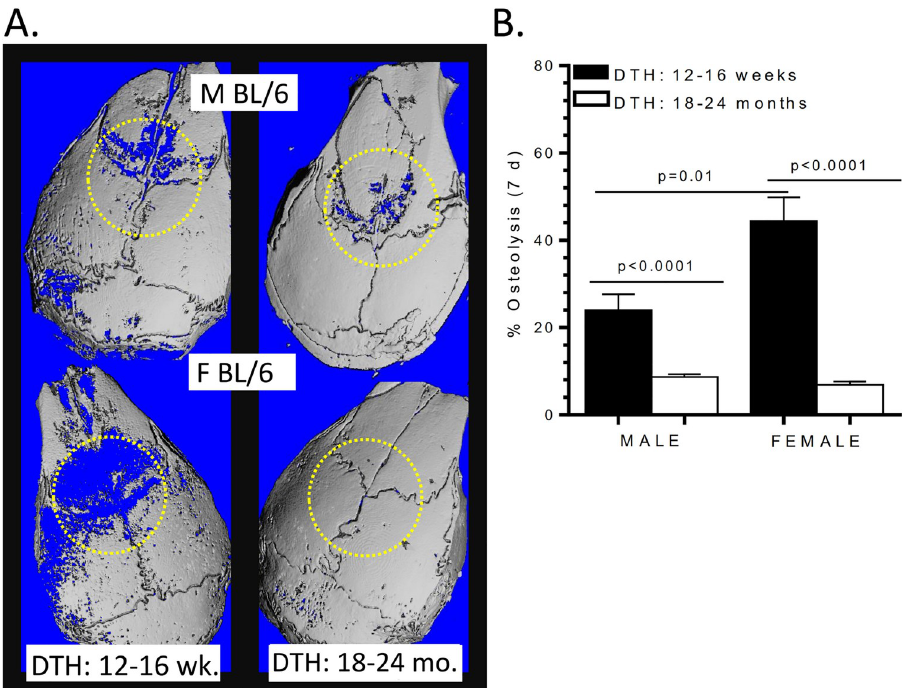
Fig 9. Young female mice are more susceptible to experiencing metal-induced PIO. Metal-DTH treated young and aged male and female BL/6 mice received 2 mg/mouse calvaria of endotoxin-free CoCrMo-alloy particles. 7 days post- particle implantation (on day 21), calvaria were retrieved and analyzed by microCT. (A) Representative images and (B) graphical representation of the percentage of particle-induced osteolysis. Data represents two independent experiments with n = 4–5 mice/group in each experiment. Data are shown as the mean ± SEM. Statistical significance was determined by unpaired Mann-Whitney